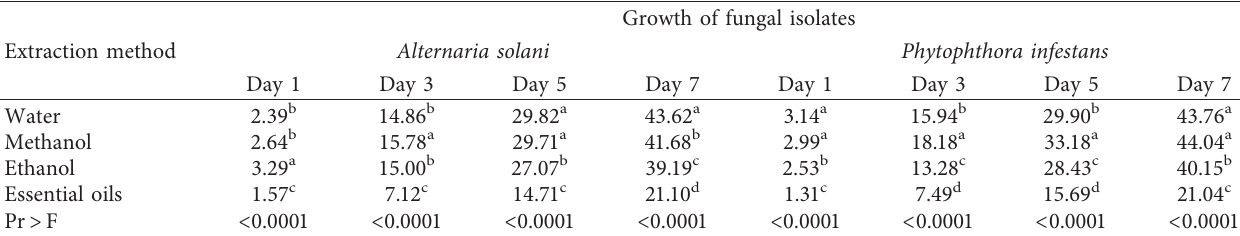
Table 5: Effect of the extraction solvents and essential oils on the growth of the test pathogens. Extraction